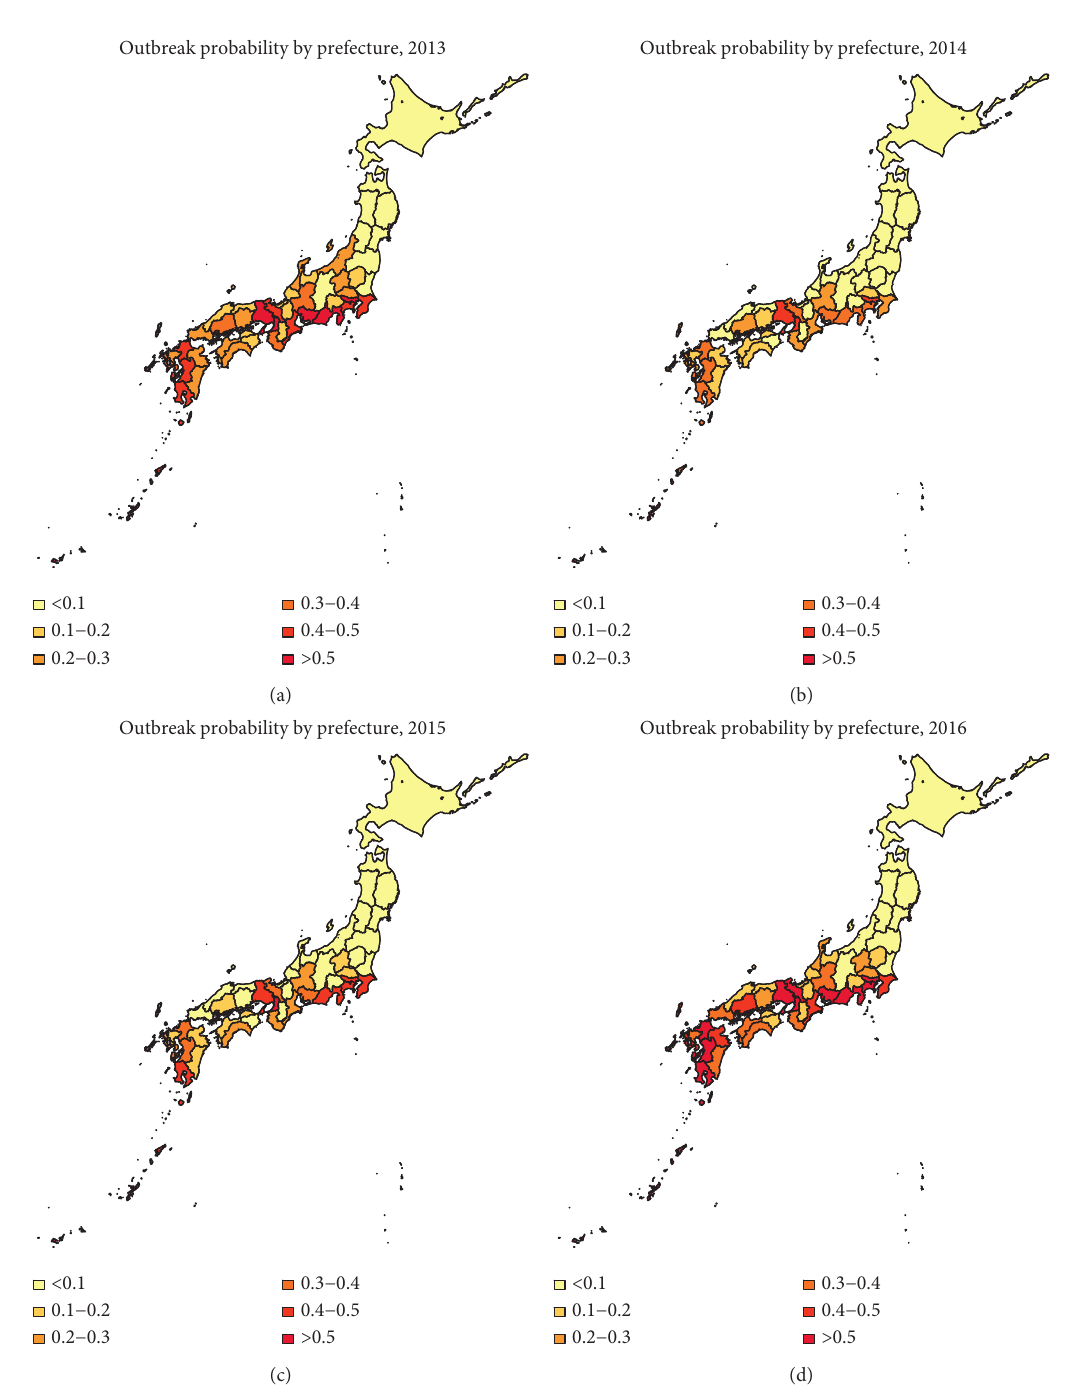
Figure 8: Heat map of the actual probability that dengue fever sustains until November; k � 0 .